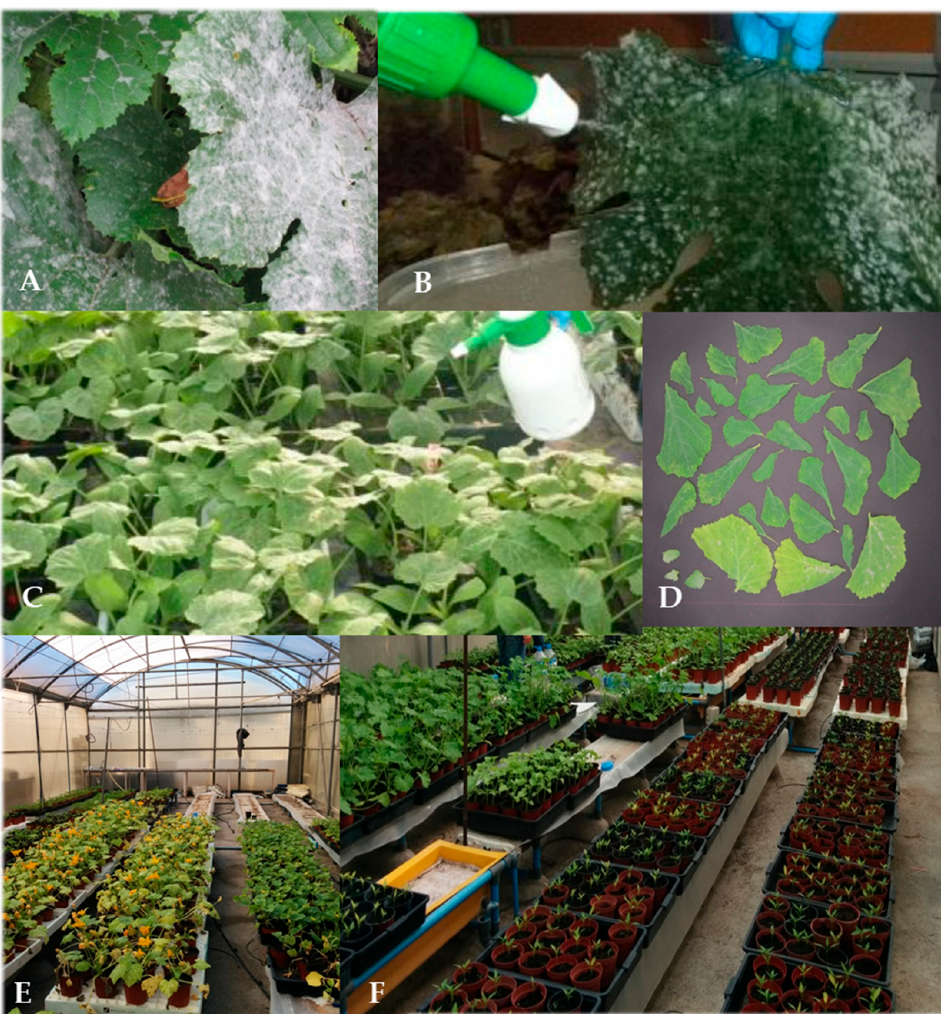
Figure 2. ( A ). Zucchini leaves with symptoms of powdery mildew caused by P. xanthii . ( B ). Application of sterile water for rinsing off spores. ( C ). Spraying of spores on healthy seedlings previously treated with P. variotii (PAE) or water (T0). ( D ). Arrangement of leaves to determine the affected leaf area. ( E , F ). Distribution of seedlings during the different assays.